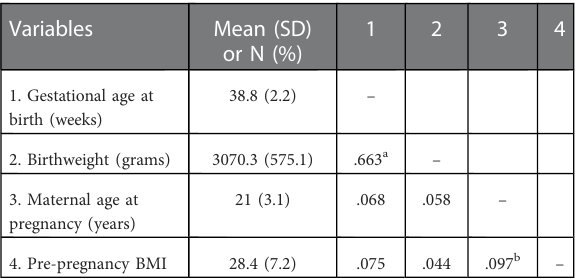
TABLE 3 Descriptive statistics and bivariate